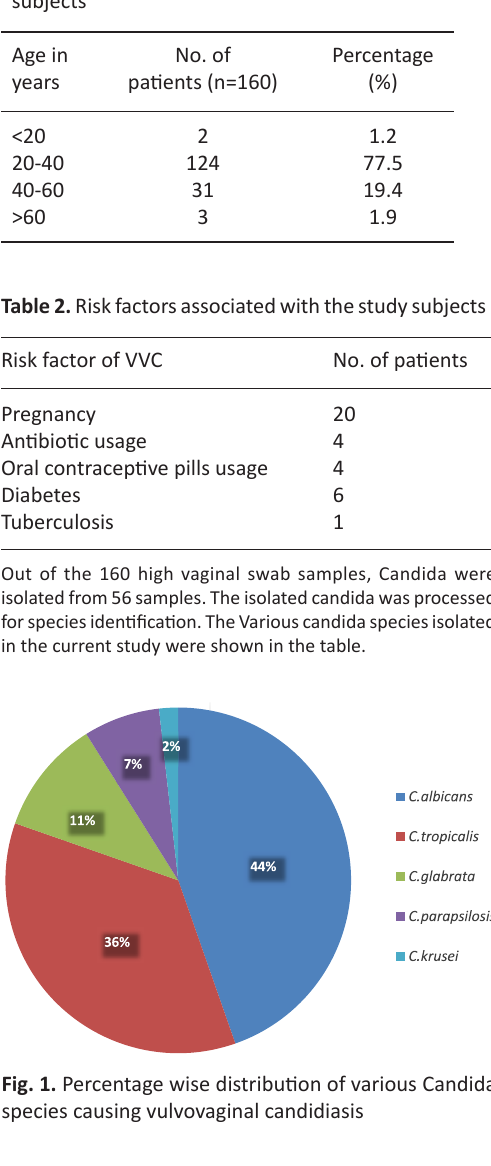
Table 1. Agewise distribution of the study